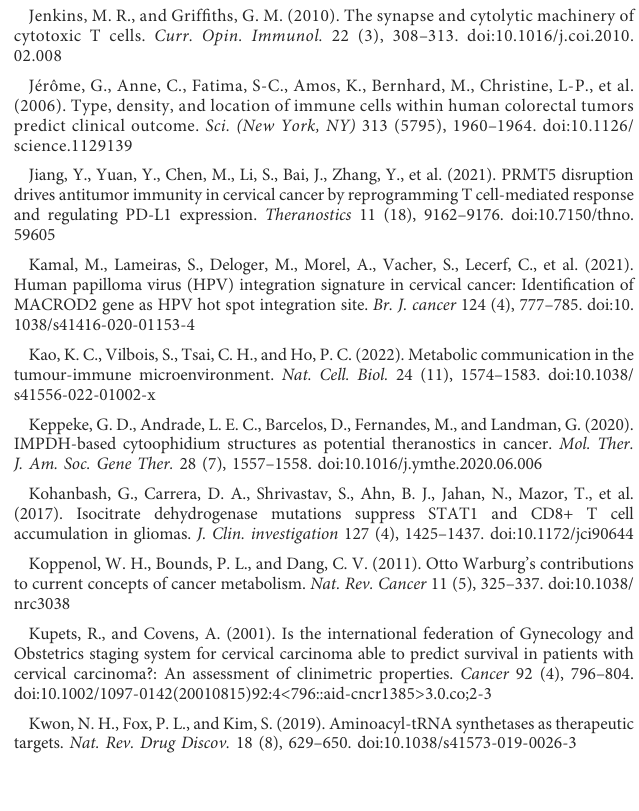
SUPPLEMENTARY FIGURE S2 Expression of TLRs and cytotoxicity related molecules and signaling. (A-C) Boxplot of the expression of TLR2, TLR3 and TLR4 among three subtypes. The differences were compared using the Kruskal-Wallis test. (D – E) Boxplot of the expression of grazyme B and IFN- γ among three subtypes. The differences were compared using the Kruskal-Wallis test. (F) Boxplot of the enrichment score of IFN- γ signaling among three subtypes. The differences were compared using the Kruskal-Wallis test. SUPPLEMENTARY FIGURE S3 Validation of the knockdown ef fi ciency of siRNA (A-C) Results of qRT-PCR